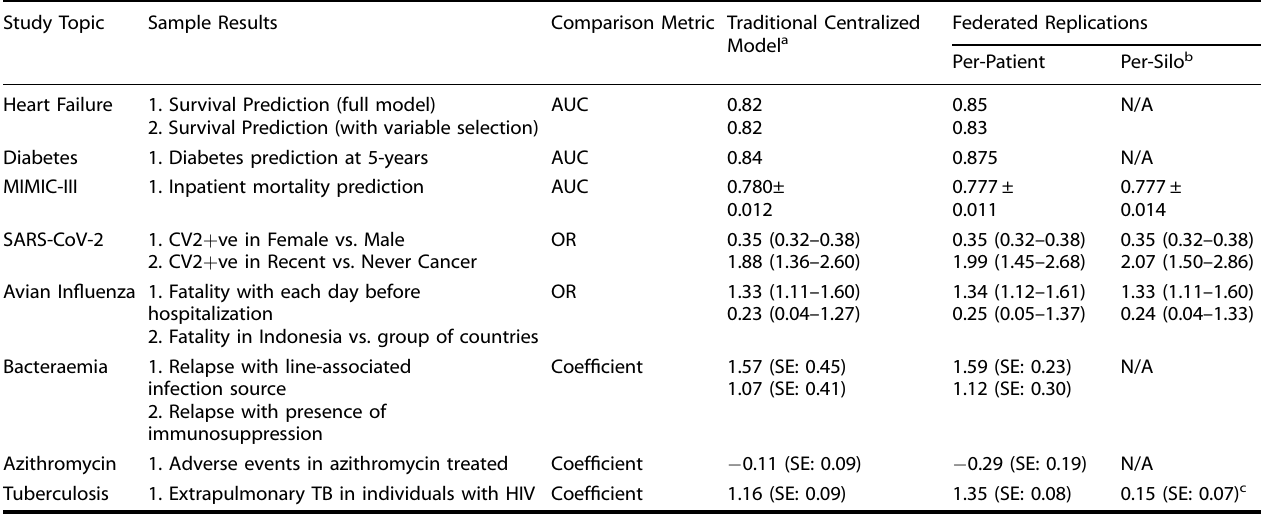
Table 2. Summary of original and federated results reproduced in this work.